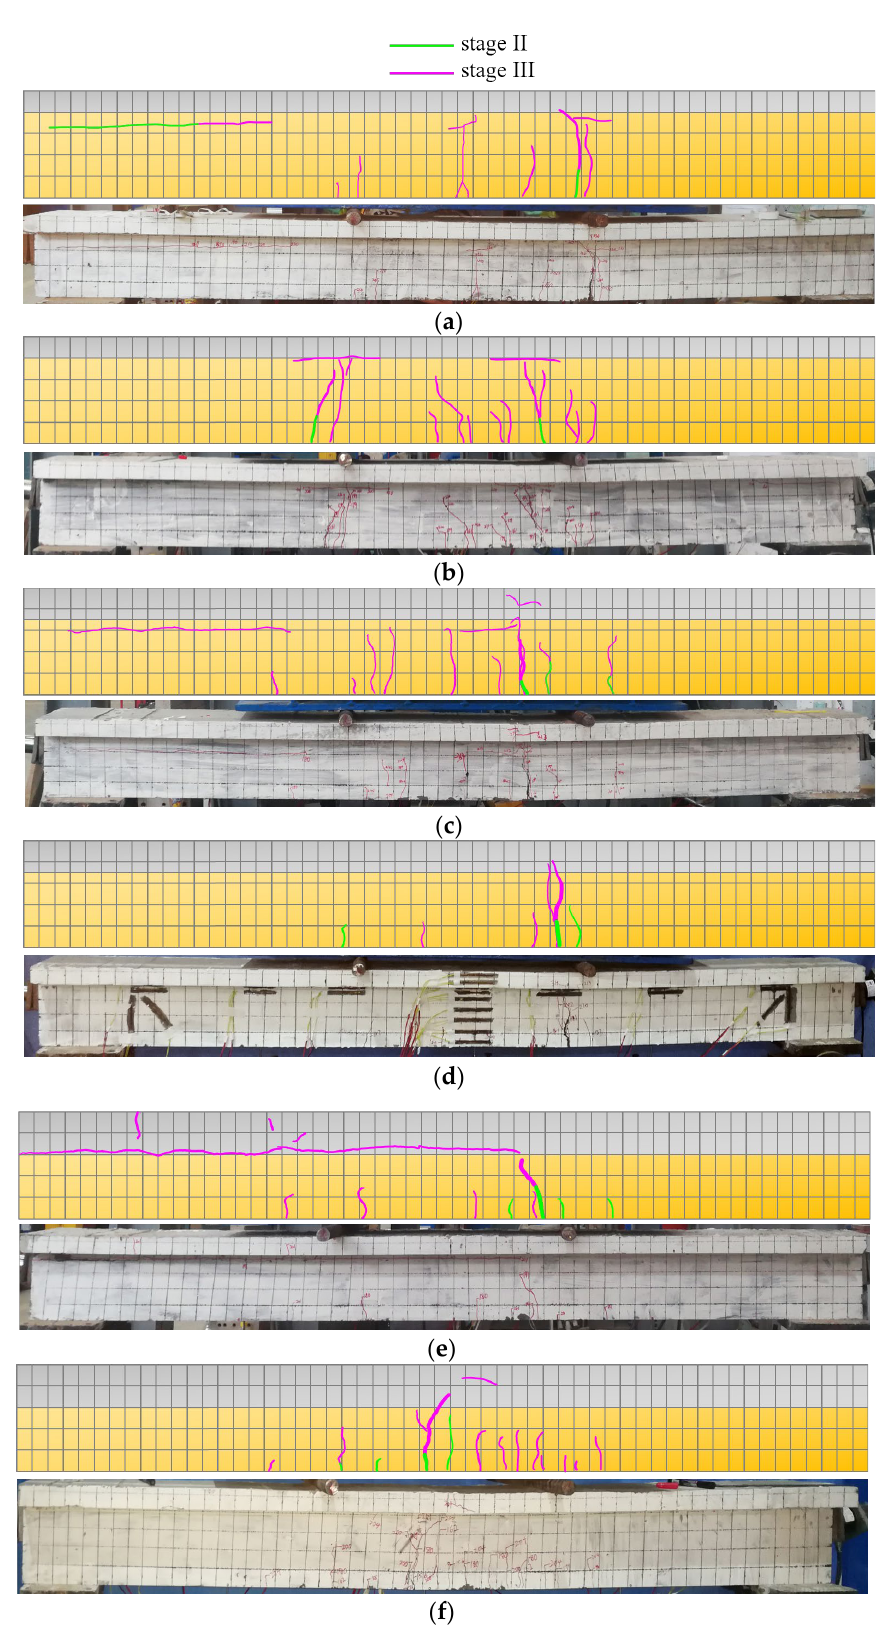
Figure 10. Crack distribution results for each beam; ( a ) B1-1; ( b ) B1-2; ( c ) B2-1; ( d ) B2-2; ( e ) B3-1; ( f ) B3-2.